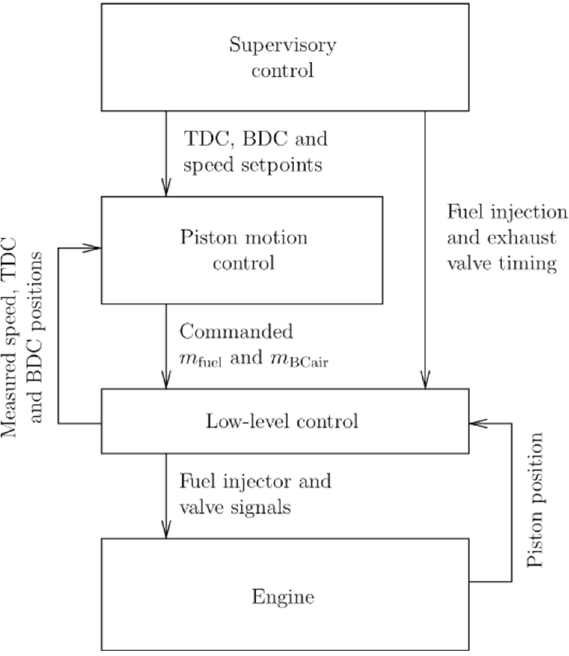
Figure 21. Free-piston engine control structure at Newcastle University [9].